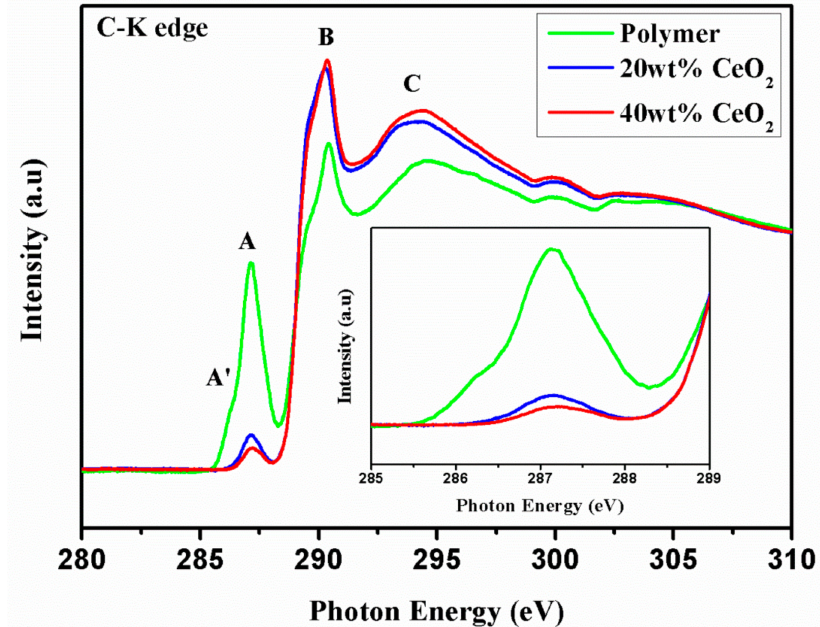
Figure 3. C-K edge X-ray absorption near-edge fine structure (XANES) of polymer, polymer composite with 20 wt% and 40 wt% CeO 2 nanoparticles (inset figure shows the magnified peak